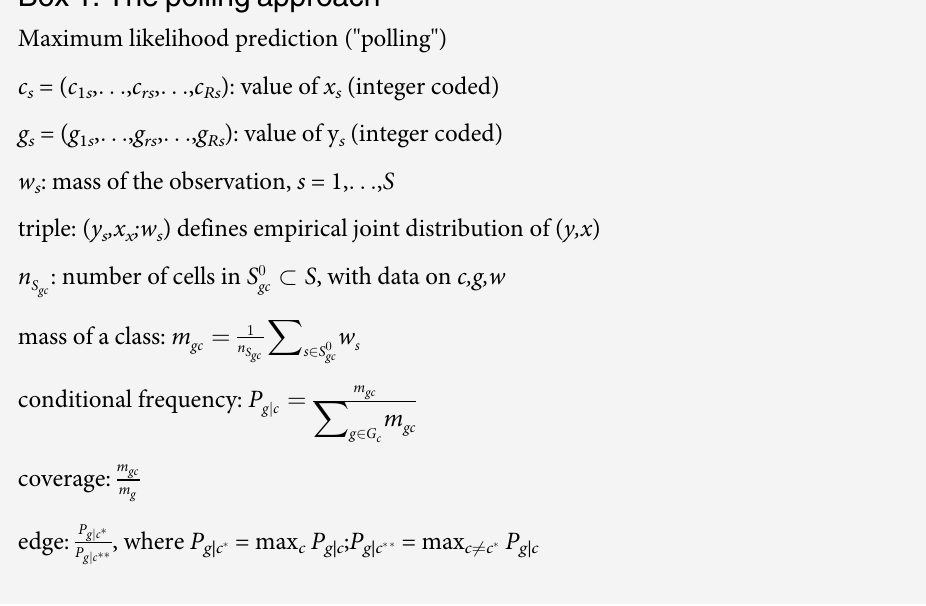
Maximum likelihood prediction